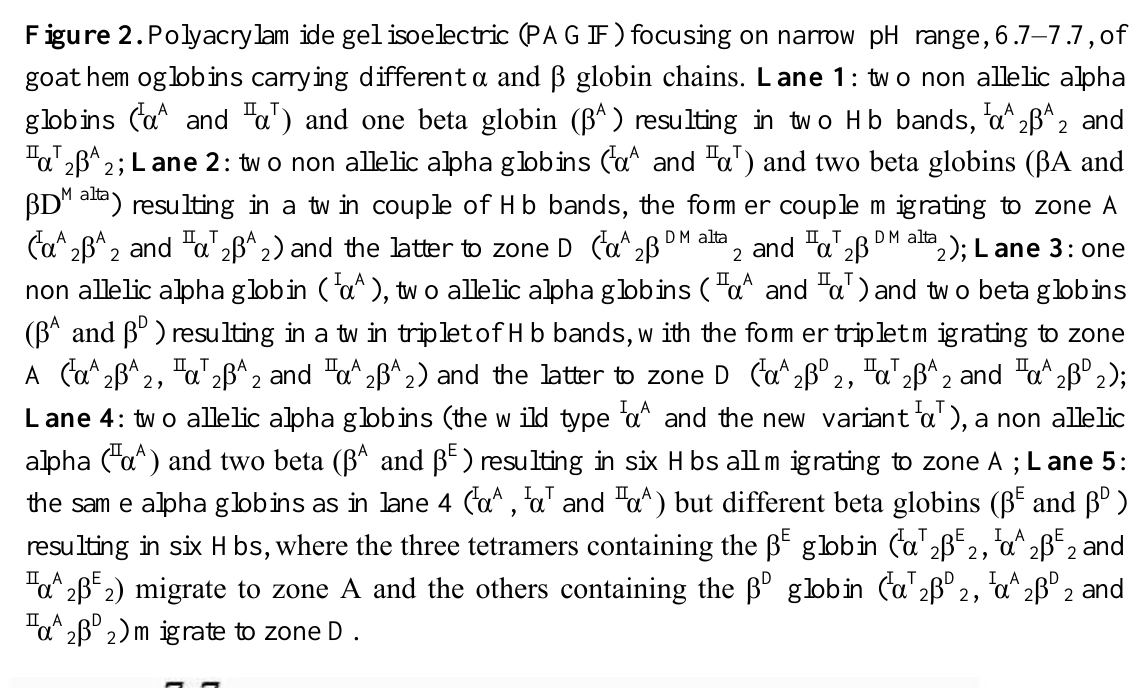
β A and 2 2 β DMalta and II α T β DMalta ); Lane 3 : 2 2 2 2